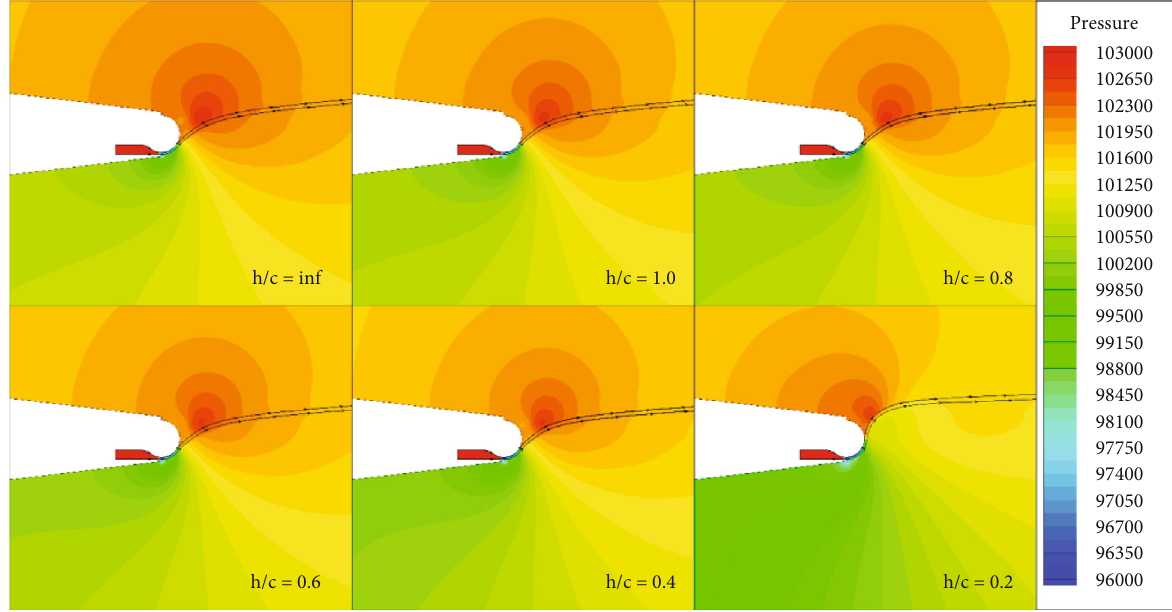
Figure 16: Pressure contours for C